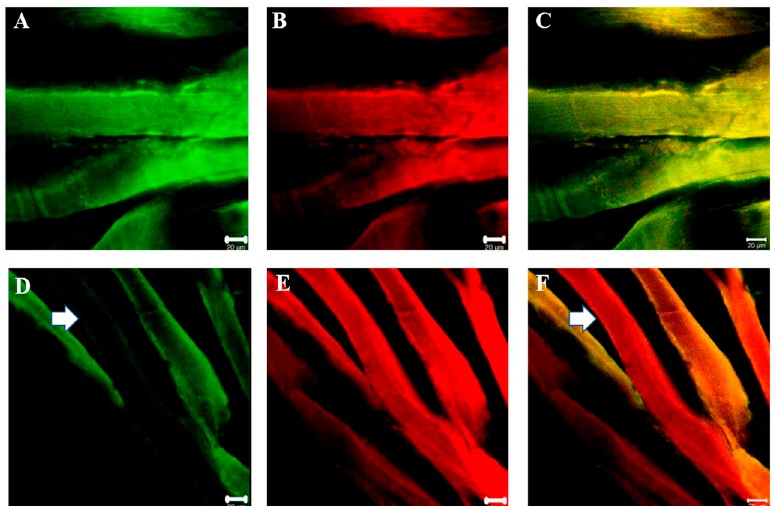
Figure 8. Compound panel of double immunofluorescence reaction between alpha-SG (green channel) and dystrophin (red channel) in sternocleidomastoid muscle of high-ranking ( A – C ) and low-ranking ( D – F ) baboons. Results show that all muscle fibers of high-ranking baboon are positive for both alpha-SG and dystrophin; instead, in low-ranking baboons, all fibers are positive for dystrophin while there are some negative fibers for alpha-SG (white arrow).